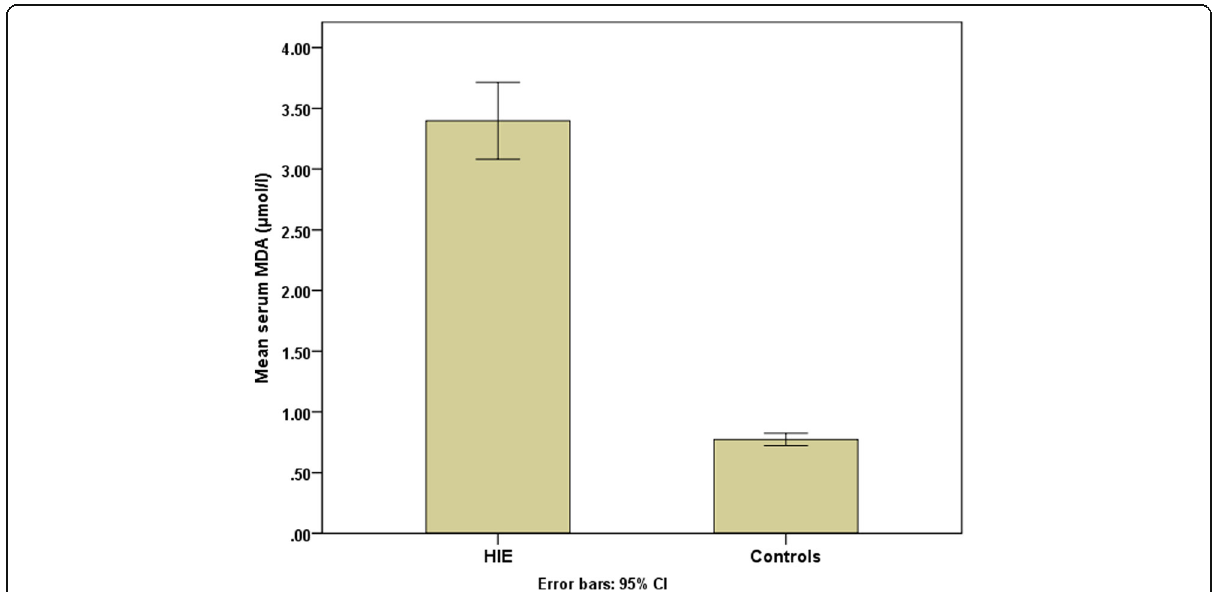
Fig. 1 Mean serum (MDA) levels in hypoxic neonates and control